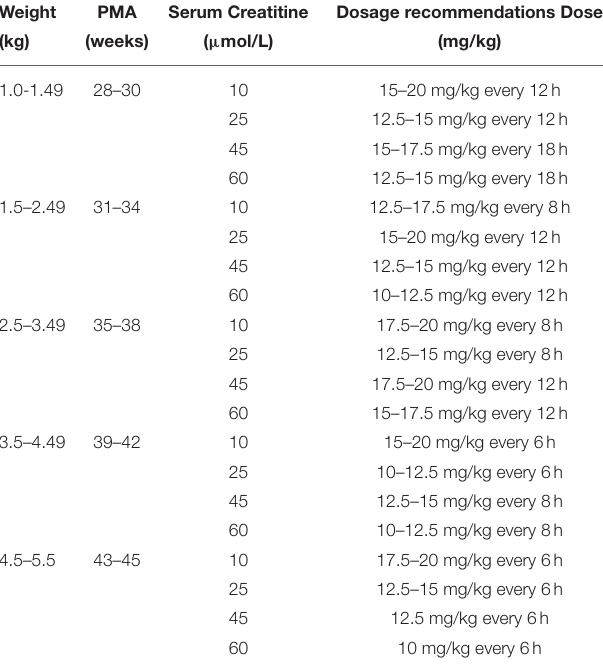
TABLE 4 | Dosage recommendations based on the final